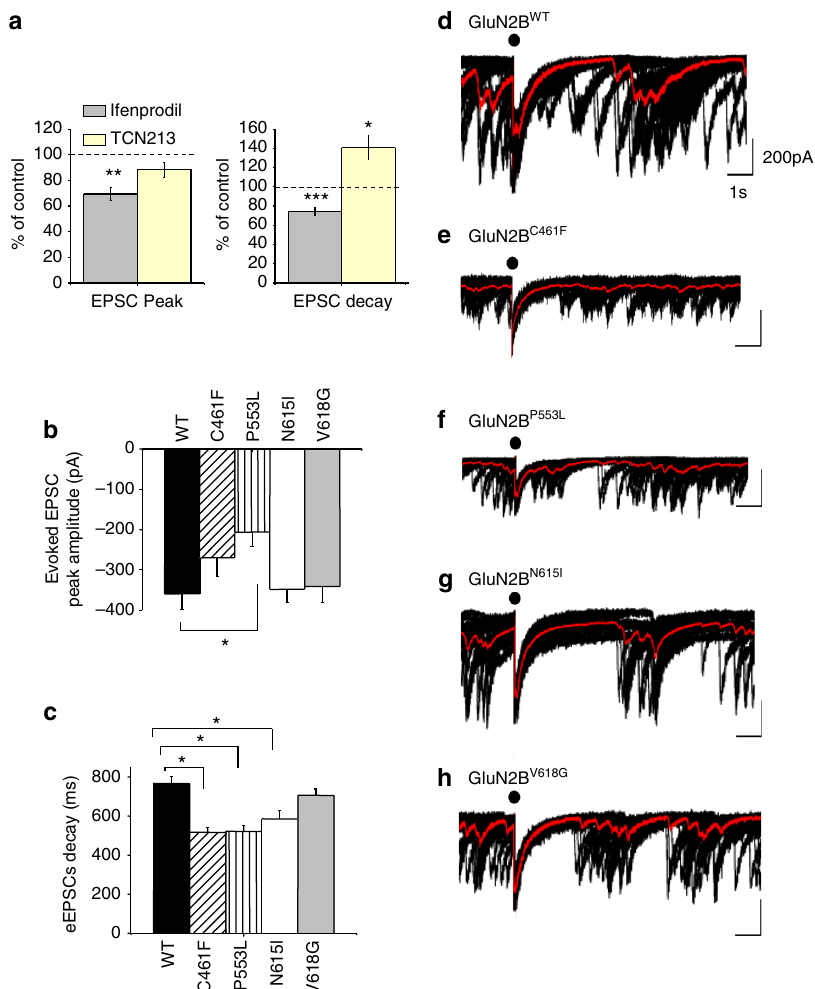
Fig. 6 GluN2B mutations and NMDAR-mediated evoked (e)EPSCs. a Pharmacological characterisation of NMDAR-mediated EPSCs from 13 – 15 DIV untransfected hippocampal neurons. Bar graphs report mean peak EPSC amplitude (left) and decay time (right) in the presence of either 3 μ M ifenprodil ( n = 15) or 30 μ M TCN213 ( n = 5), as a percentage of control EPSC values (dashed line, = 100%). All bars are mean ± s.e.m. Two-tailed paired t -test * p < 0.05; ** p < 0.005; *** p < 0.0005. b , c Bar graphs of peak amplitude ( b ) and weighted decay time constant ( c ) for evoked EPSCs for GluN1 – GluN2B WT and GluN2B mutant NMDARs. One-way ANOVA with Dunnett ’ s post-hoc test * p < 0.05. d – h Evoked and spontaneous EPSCs recorded at − 70 mV from hippocampal neurons expressing GluN2B WT ( d ), GluN2B C461F ( e ), GluN2B P553L ( f ), GluN2B N615I ( g ) and GluN2B V618G ( h ). In this and succeeding fi gures, red traces represent averaged EPSCs of 20 sweeps and the black dots indicate the presynaptic stimulation time point. Numbers of cells ( n ): GluN2B WT n = 25, GluN2B C461F 9, GluN2B P553L 15, GluN2B N615I 11, GluN2B V618G 13. Calibration in d applies to other panels e –